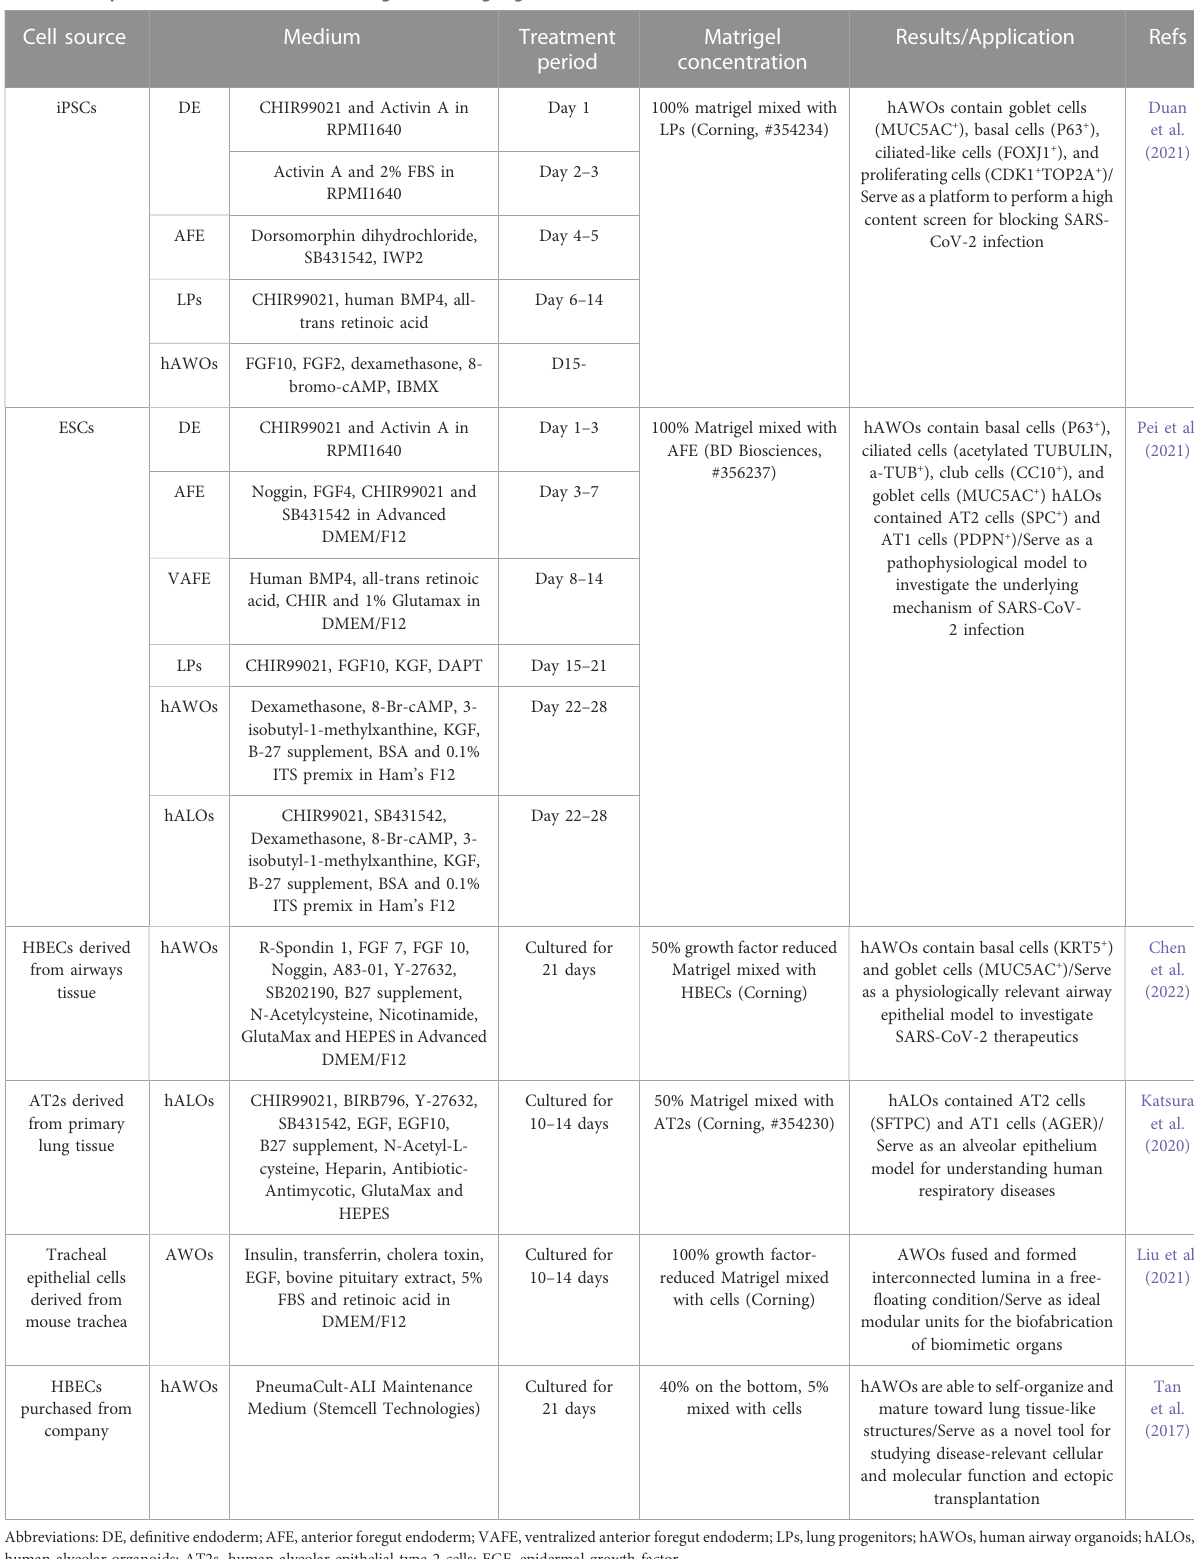
TABLE 2 The process of different cell source to generate lung